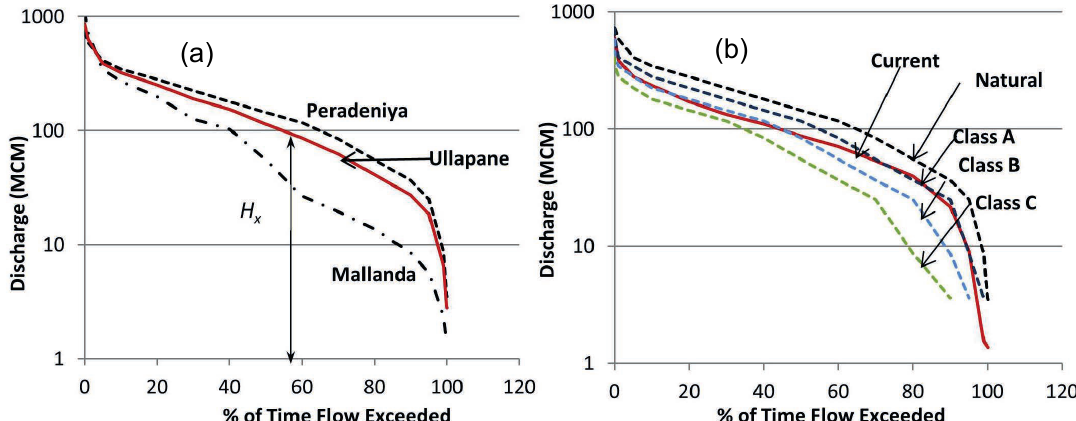
Fig. 3 (a) Simulated Natural FDC of Ullapane (continuous line) and (b) Natural and Environmental FDCs of Peradeniya (dashed lines) compared with the current flow regime (continuous